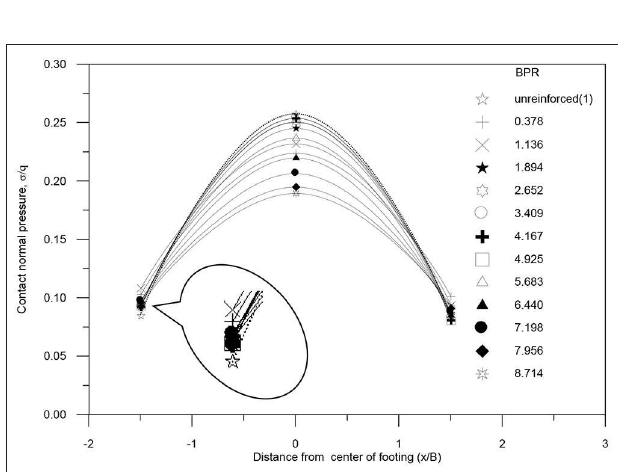
FIGURE 6 | Contact pressure distribution on subgrade soil for b / B = 12 (test